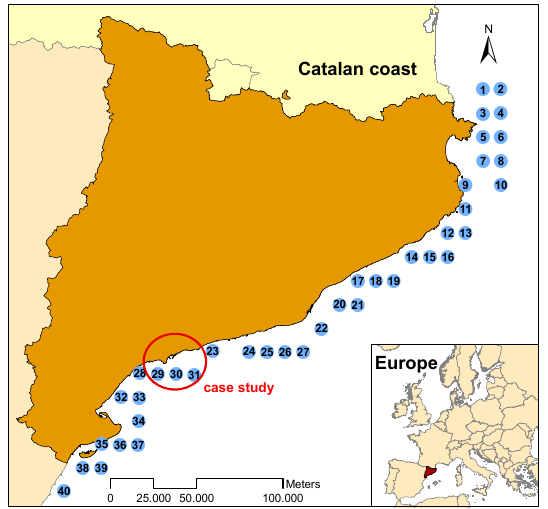
Fig. 1. Location of the Catalan coast and simulated nodes considered in this